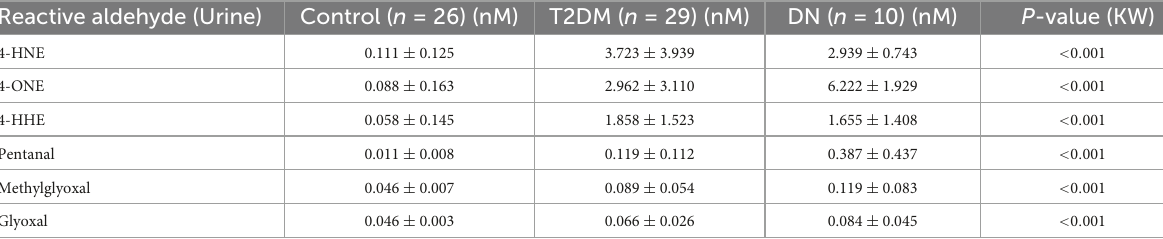
TABLE 3 Reactive aldehydes in urine (mean ± SD). Reactive aldehyde